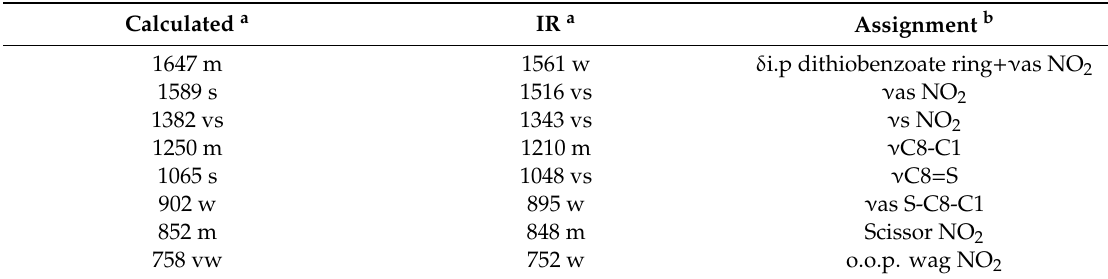
Table 2. Selected calculated (B3LYP / 6-31 + G(d,p)) and experimental IR frequencies (cm − 1 ), relative intensities, and tentative assignments of the main fundamental vibrational modes of